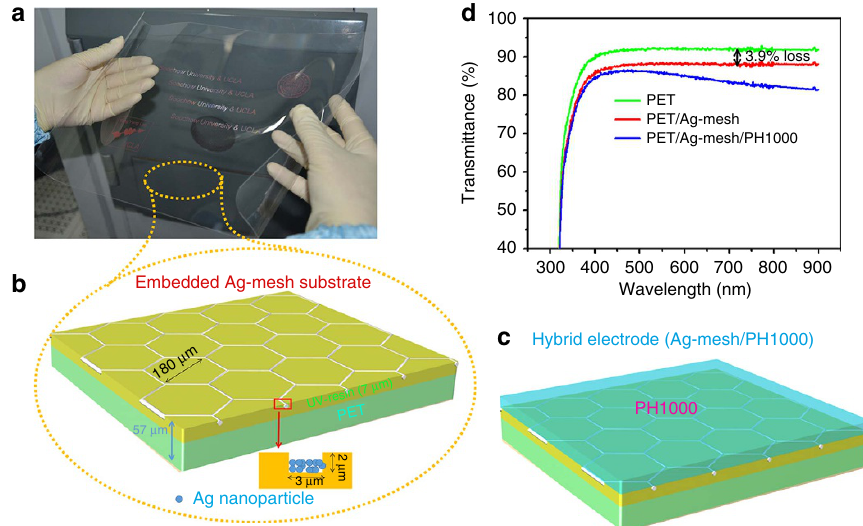
Figure 1 | Schematic illustration of the FEAMs substrate and hybrid electrode. ( a ) An image of the large-area FEAMs substrate. ( b ) The structure of the FEAMs substrate with detail parameters. ( c ) The diagram for the hybrid electrode (PET/Ag-mesh/PH1000). ( d ) Transmission spectra of bare PET, PET/ Ag-mesh, PET/Ag-mesh/PH1000-based